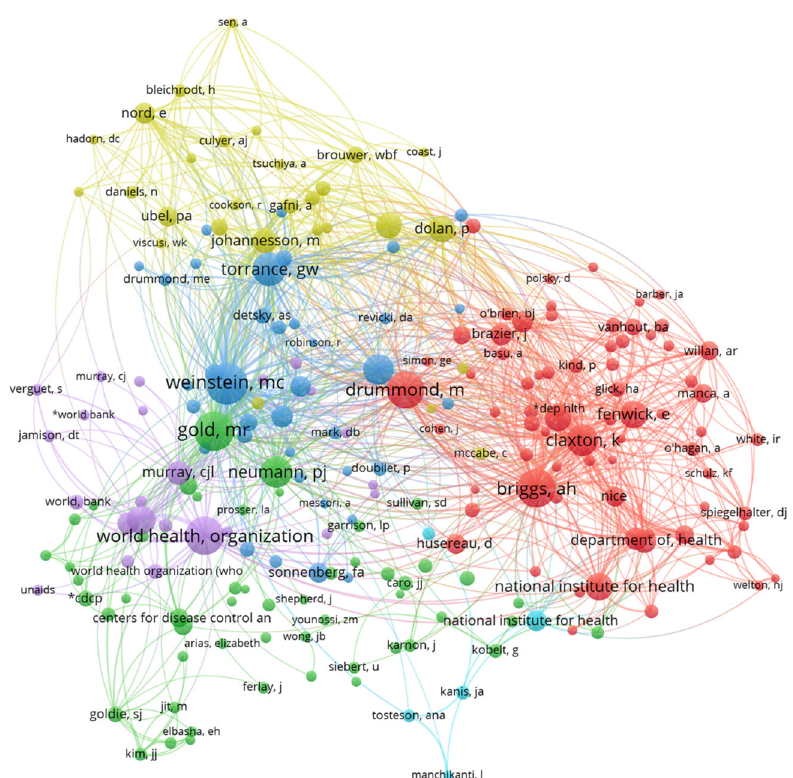
Fig. 9 Co-citation network by authors. Source: